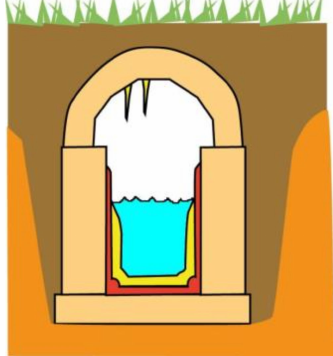
Figure 4. Typical cross-section of a Roman aqueduct channel. The channel is built of masonry and lies in an excavation in the soil. The inside is covered with a red waterproof cement (opus signinum—in red), with characteristic quarter rounds to seal the edges. Carbonate deposits (yellow) are common in some channels